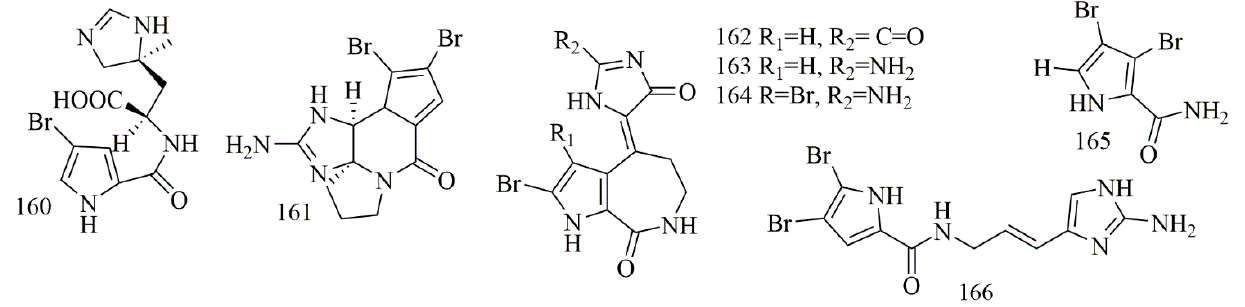
Figure 13. Pyrrole and bromopyrrole alkaloid structures from sponges. Table 13. Cytotoxic effects of pyrrole and bromopyrrole alkaloids.